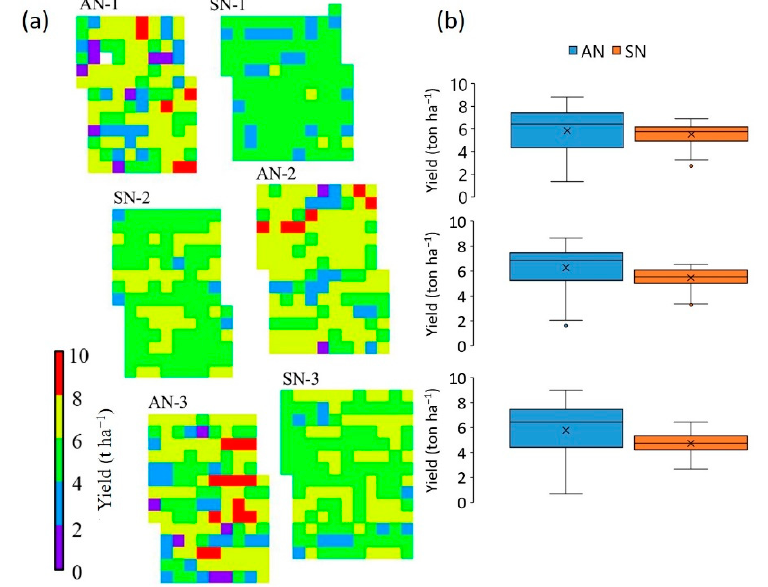
Figure 9. The plots show 2D variations in simulated barley yield ( a ) and the corresponding box and whisker plots ( b ) at the Gyeongsang National University field in 2021. AN = autumn-sown with nitrogen (N) treatments of 40% (32 kg ha − 1 ) at seeding, 30% (24 kg ha − 1 ) at rejuvenation, and 30% (24 kg ha − 1 ) at early reproduction (N40-30-30); SN = spring-sown N40-30-30. The numbers adjacent to the dash symbols represent experimental blocks. Error bars and boxes represent the yield data’s 10th, 25th, 75th, and 90th percentiles, presenting the median (solid line) and mean (×).